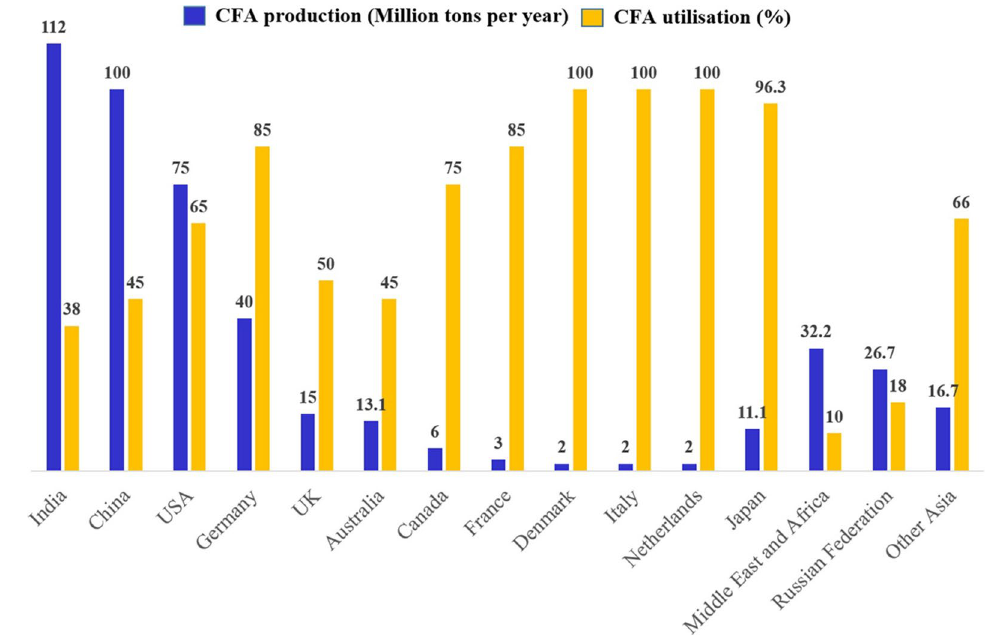
Fig. 1 CFA production and utilization (Gollakota et al. 2019)